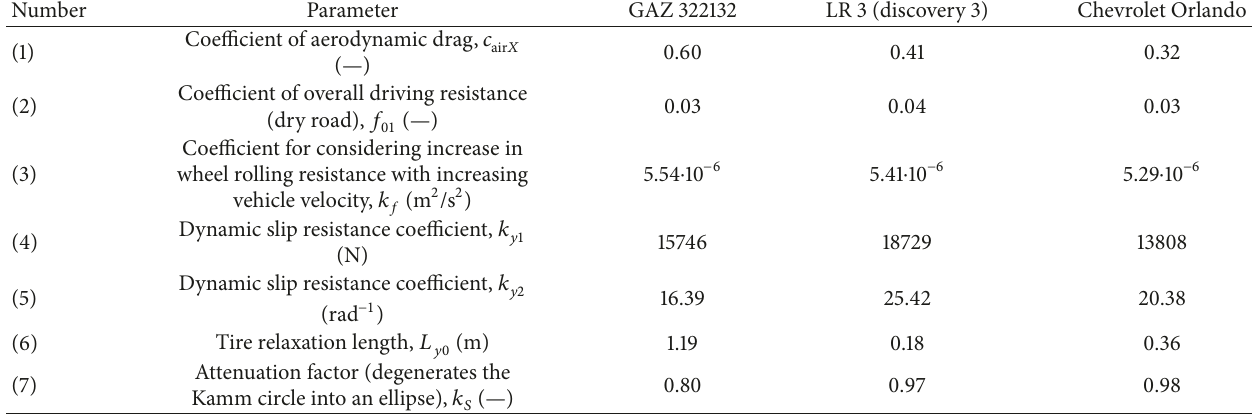
Table 1: Adjusted parameters of mathematical model for different cars.